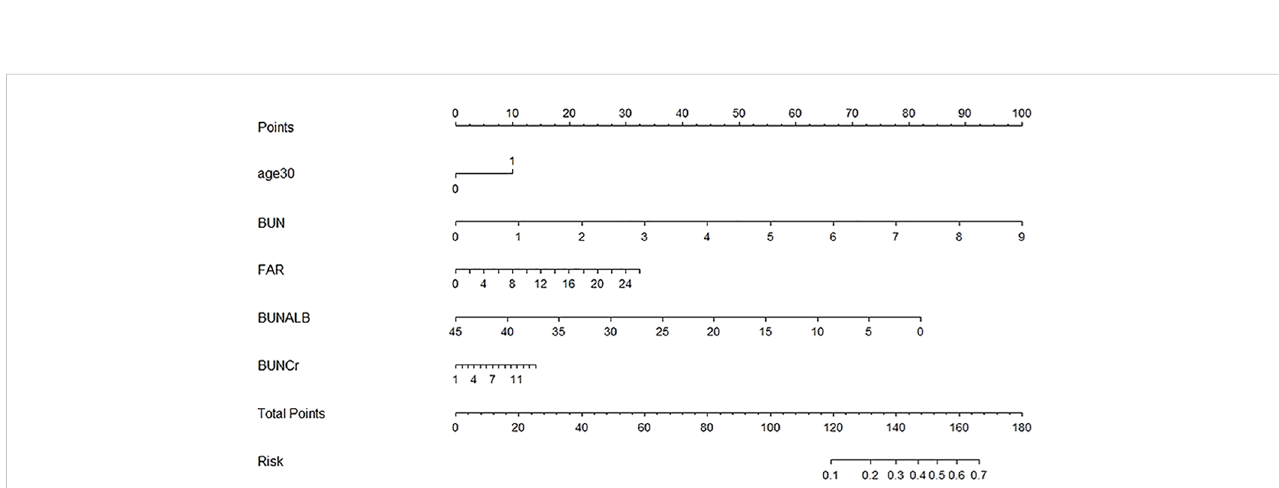
FIGURE 3 Nomogram to estimate the probability of GDM. A nomogram used basic pregnancy fi le information to predict GDM. Find the predictor points on the uppermost point scale that correspond to each variable of the pregnant woman and add them up; the total points projected to the bottom scale indicate the probability of